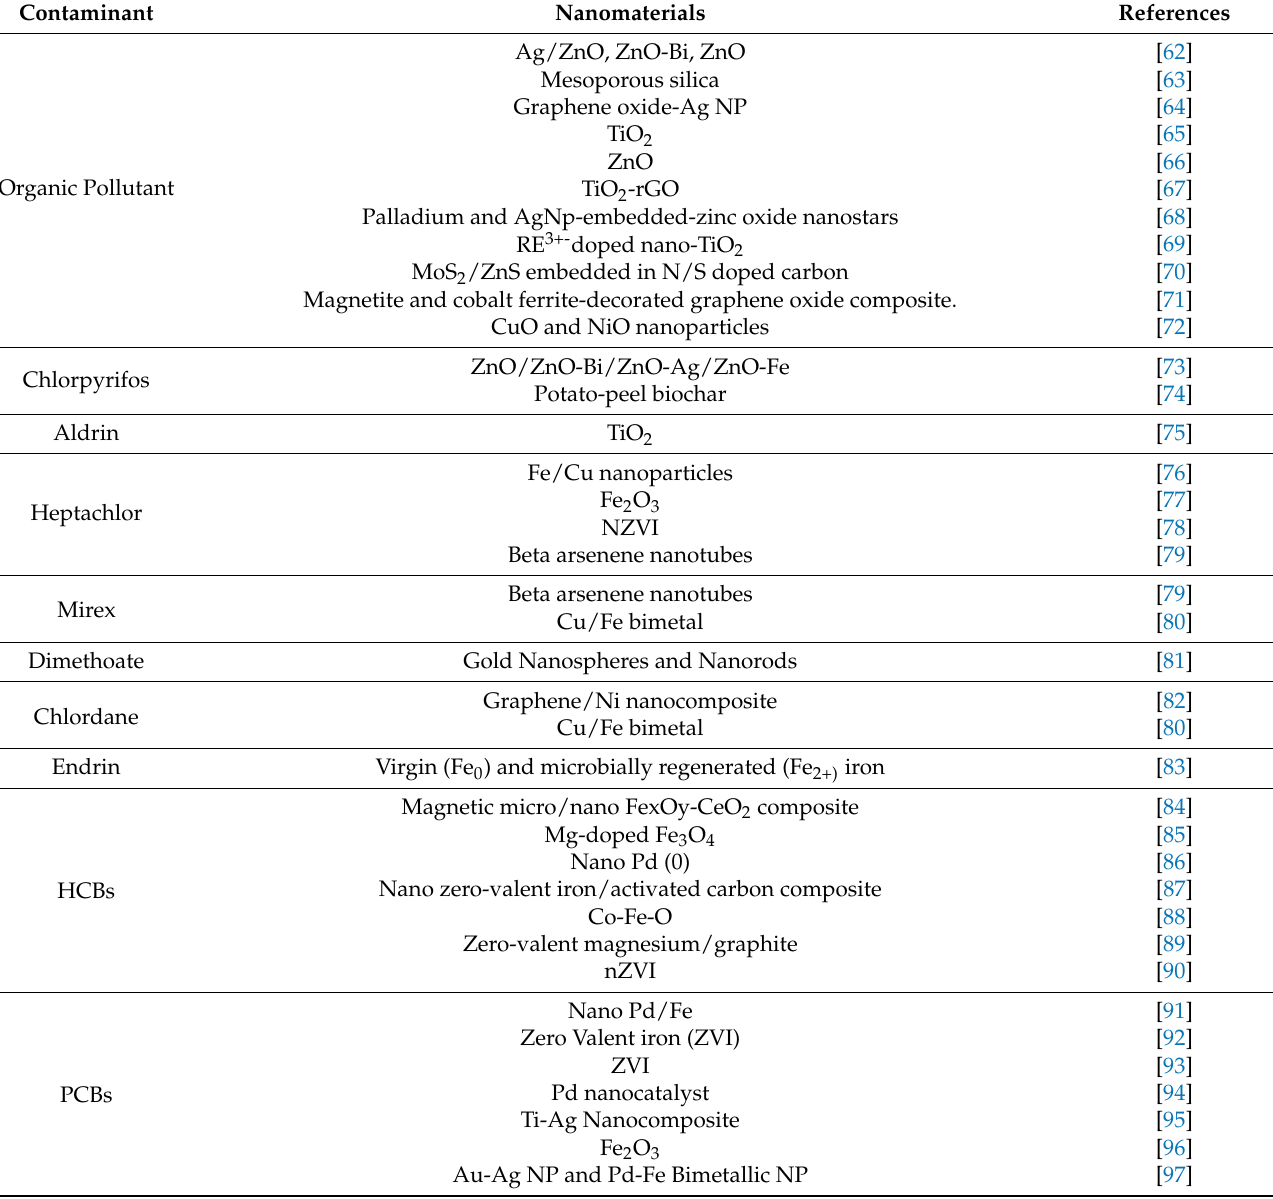
Table 4. Nanomaterials are used for the removal of